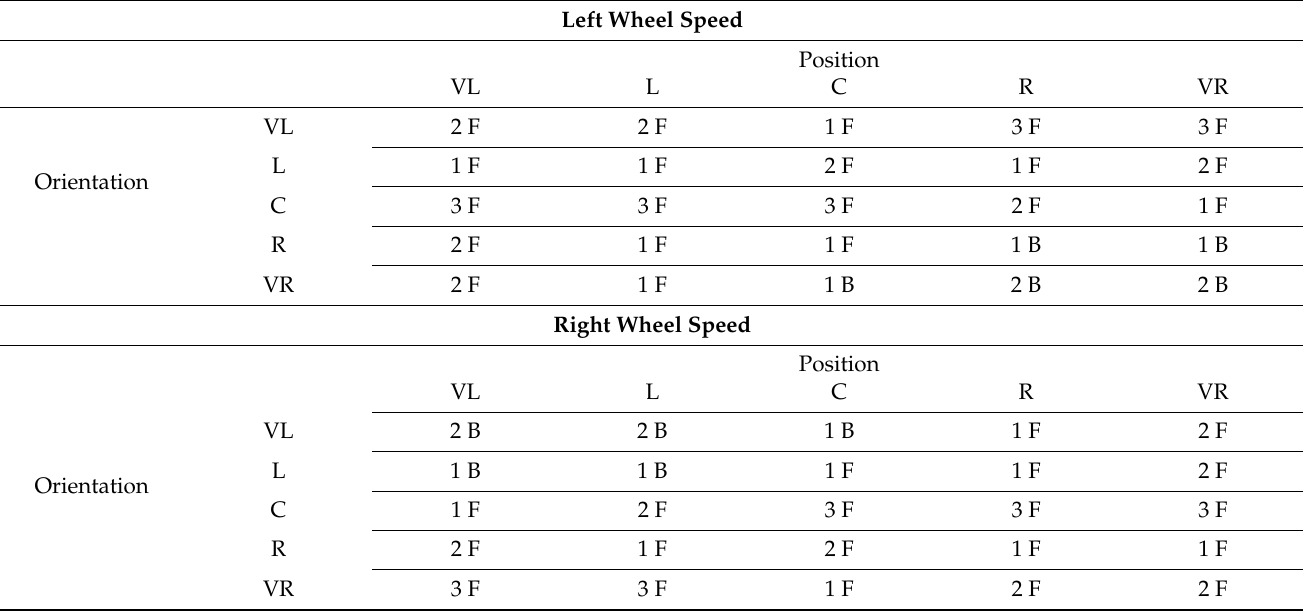
Table 1. A more classical representation of the controller rules. L: left, R: right, V: very, C: center, 1: slow, 2: medium, 3: maximum, F: forward, B: